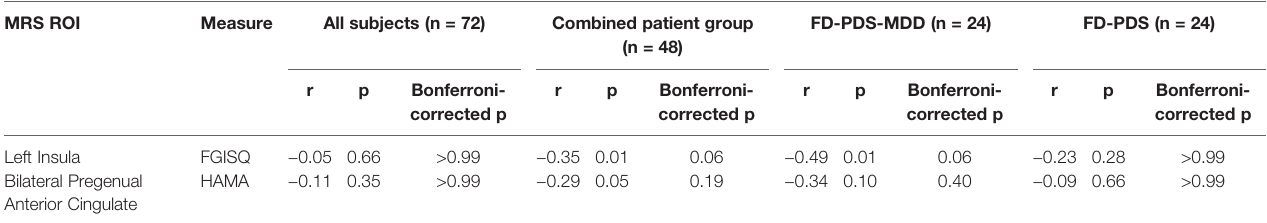
TABLE 5 | Correlations between GABA/water and clinical measures.